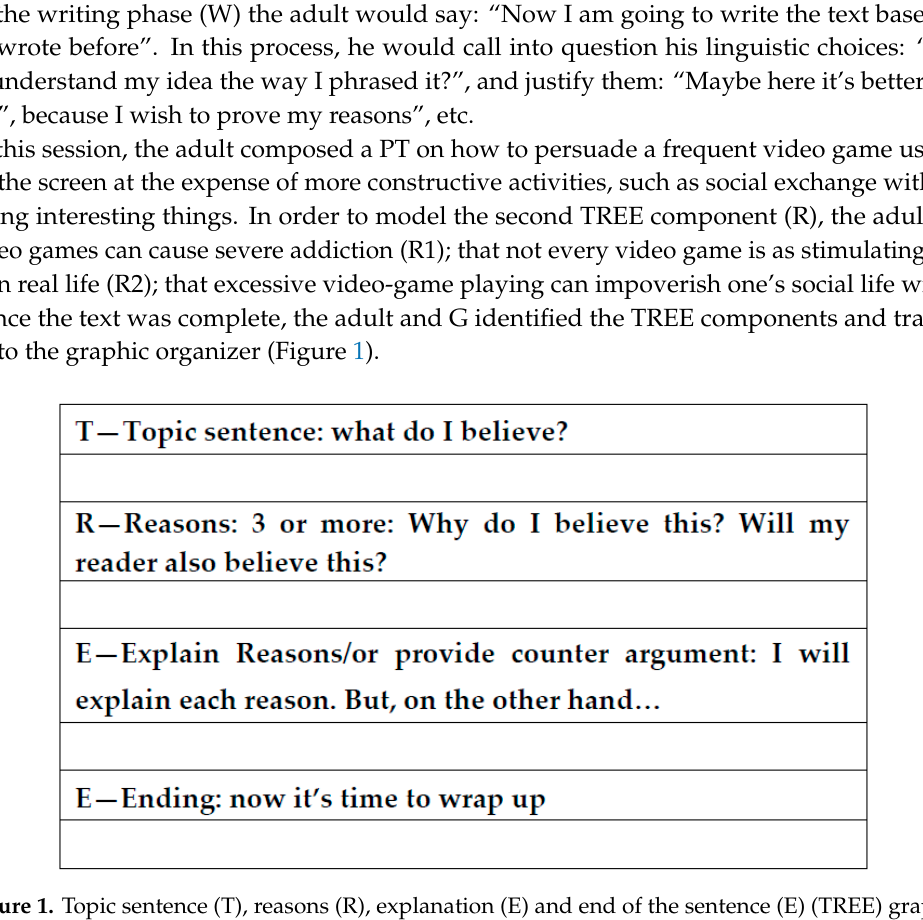
Figure 1. Topic sentence (T), reasons (R), explanation (E) and end of the sentence (E) (TREE) graphic organizer—Graham and Harris. Adapted from Asaro-Saddler and Bak [15,369] with some